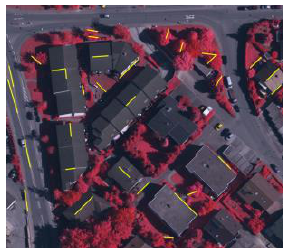
Figure 7. The optimized extraction of line features on the remote sensing